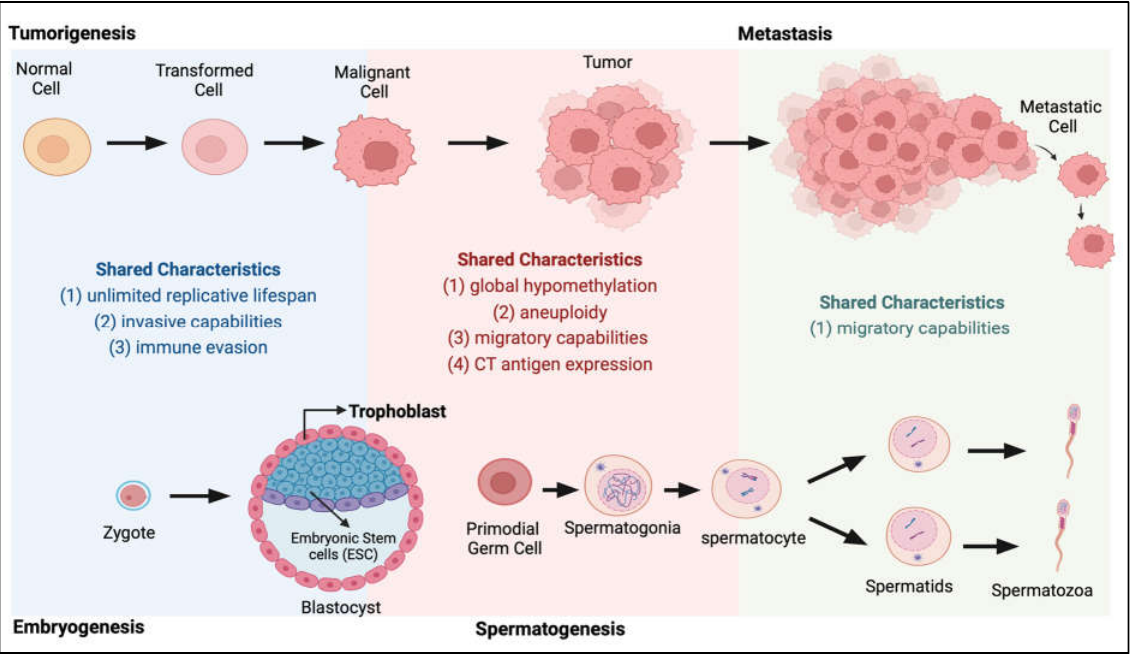
Figure 1. Shared characteristics between tumorigenesis and embryogenesis and spermatogenesis. During the transition from normal to tumour and metastasis (top panel), cancer cells acquire many characteristics highly similar to those present during normal development (bottom panel) when the zygote develops into an embryo and during the spermatogenesis process.